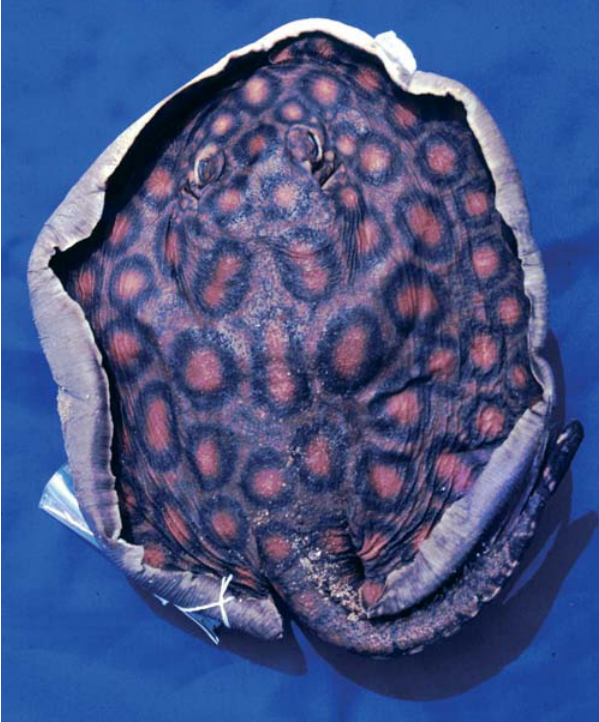
Fig. 3. Potamotrygon boesemani . Dorsal view of paratype (USNM 225575, 250 mm DW), from Corantijn